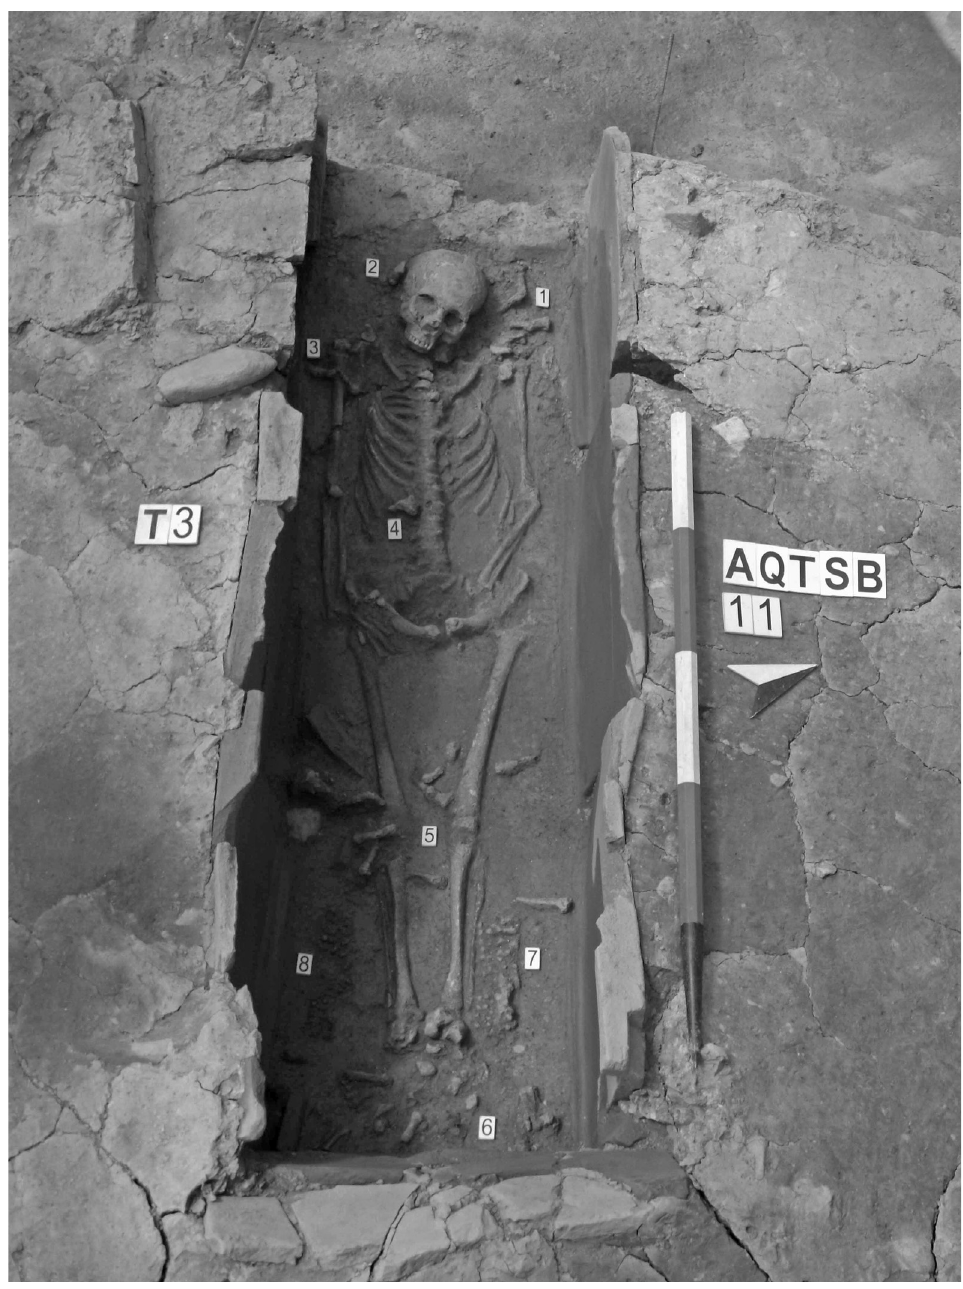
Figure 4: Acqui Terme, tomb no. 3. Skeleton with the indication of the nails (photo Melania Cazzulo © Soprintendenza Archeologia del